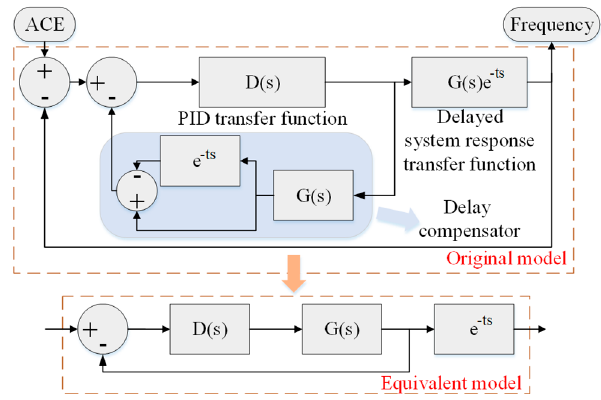
Figure 8. Control framework of time-delay systems with delay compensator.